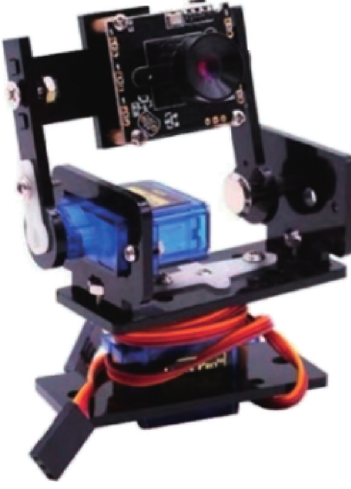
Figure 4: Two-axis PTZ camera.